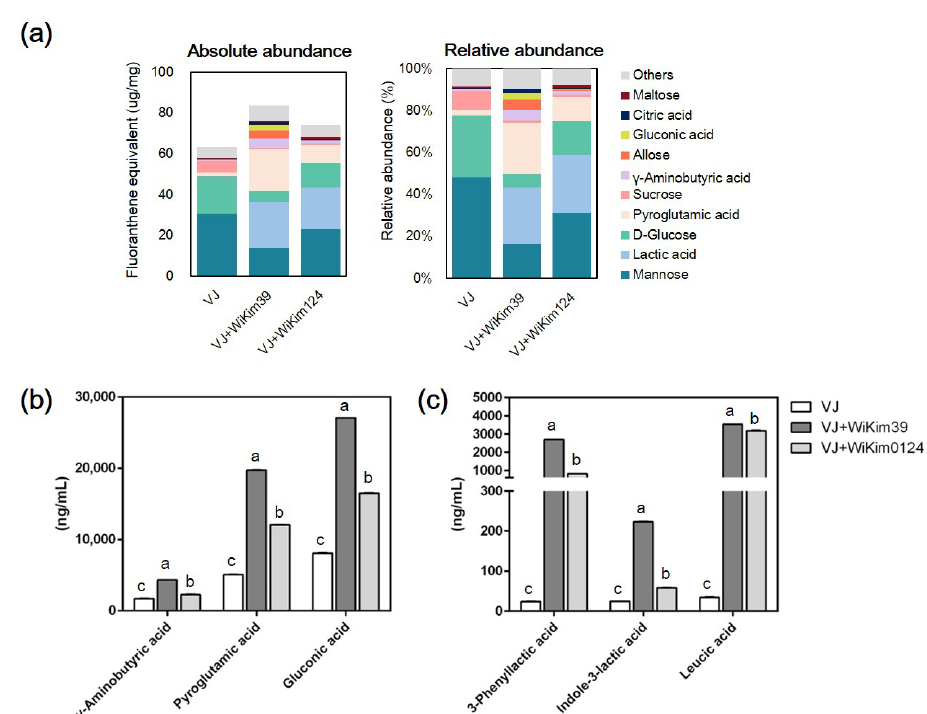
Figure 2. Identification of phytochemical profile in fermented or non-fermented vegetable juice. ( a ) GC-MS profile of the top 10, most abundant phytochemicals. ( b , c ) Quantification of signifi- cantly differentiated compounds from GC-MS or UPLC-QTOF-MS/MS using UPLC-QTOF-MS/MS. (Details of ion chromatograms are shown in Supplementary Figures S1 and S2). GC-MS: gas chromatography-mass spectrometry, UPLC-QTOF-MS/MS: ultra-performance liquid chromatogra- phy with quadrupole time-of-flight tandem mass spectrometry. Different letters denote significant differences ( p < 0.05, ANOVA,